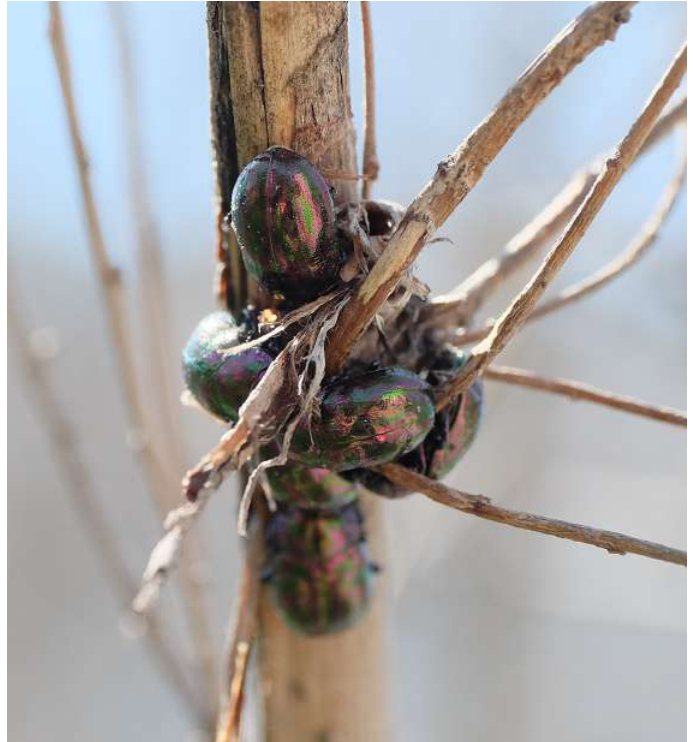
Figure 6. Ambrostoma superbum on Ulmus pumila